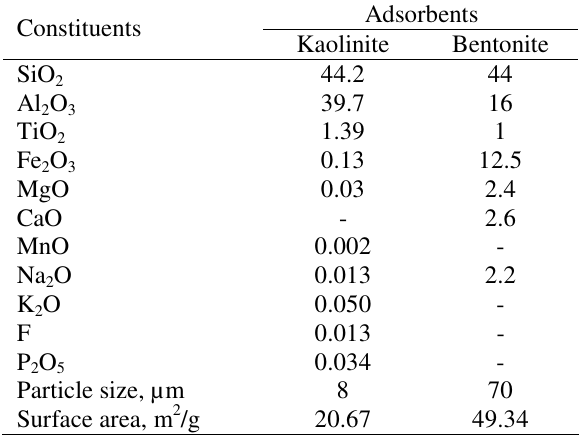
Table 1. Chemical composition * and granulometry of kaolinite and bentonite Adsorbents Constituents Kaolinite